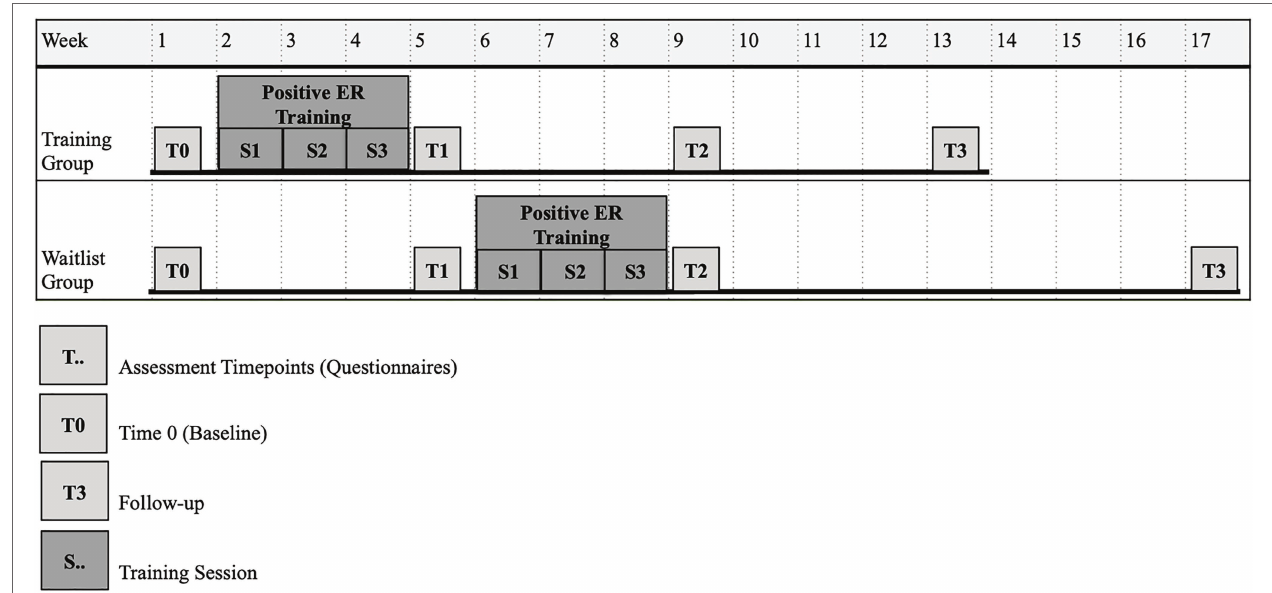
FIGURE 1 | Study timeline of training sessions and questionnaires administered over the